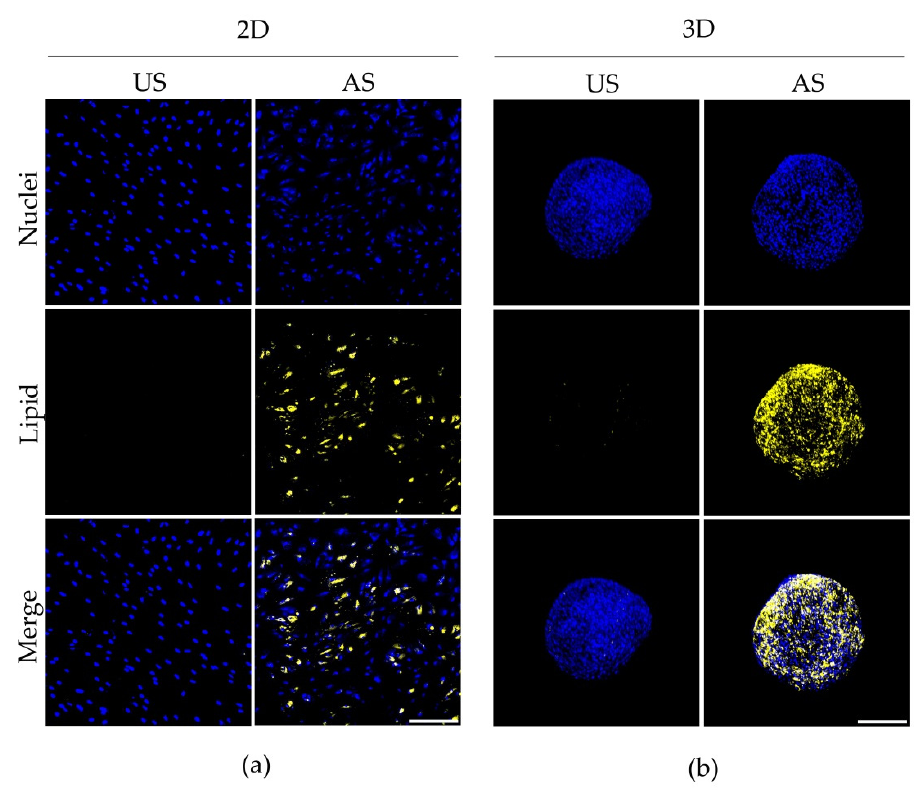
Figure 3. Lipid accumulation in unstimulated (US) and adipogenically stimulated (AS) adMSC after 14 days in ( a ) 2D and ( b ) 3D cultures (representative images from n = 3; lipid accumulation: yellow; nuclei: blue; confocal microscopy; scale bar: 200 µm).